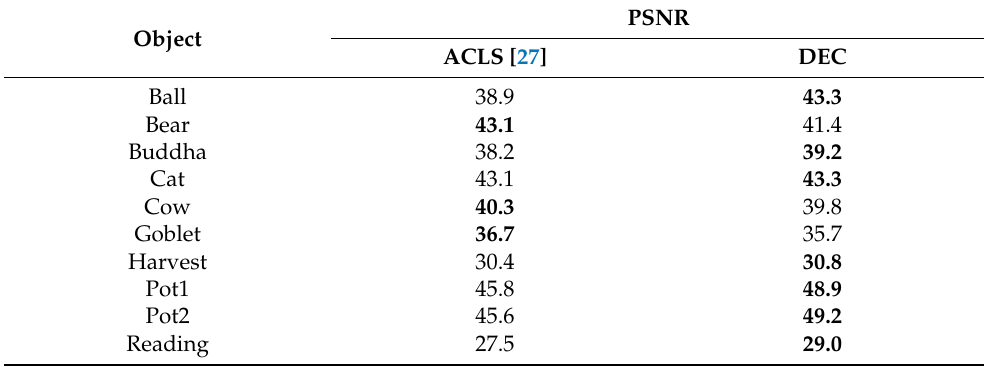
Figure 6. Visual comparison on the Harvest, Reading, and Ball dataset: ( a ) Ground truth photograph; ( b ) Alldrin et al. [27]; ( c ) Ours; ( d ) Highlighted regions in ( a – c ). Table 3. Comparison of PSNR with ACLS for the “DiLigenT” dataset. We generated the reconstruction results using the ground truth surface normal for both